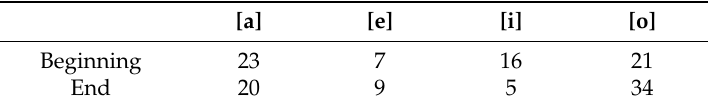
Table A12. Token counts for vowel formant measurements used to assess changes in individual vowel production by Informant D in Section 4.2.4.